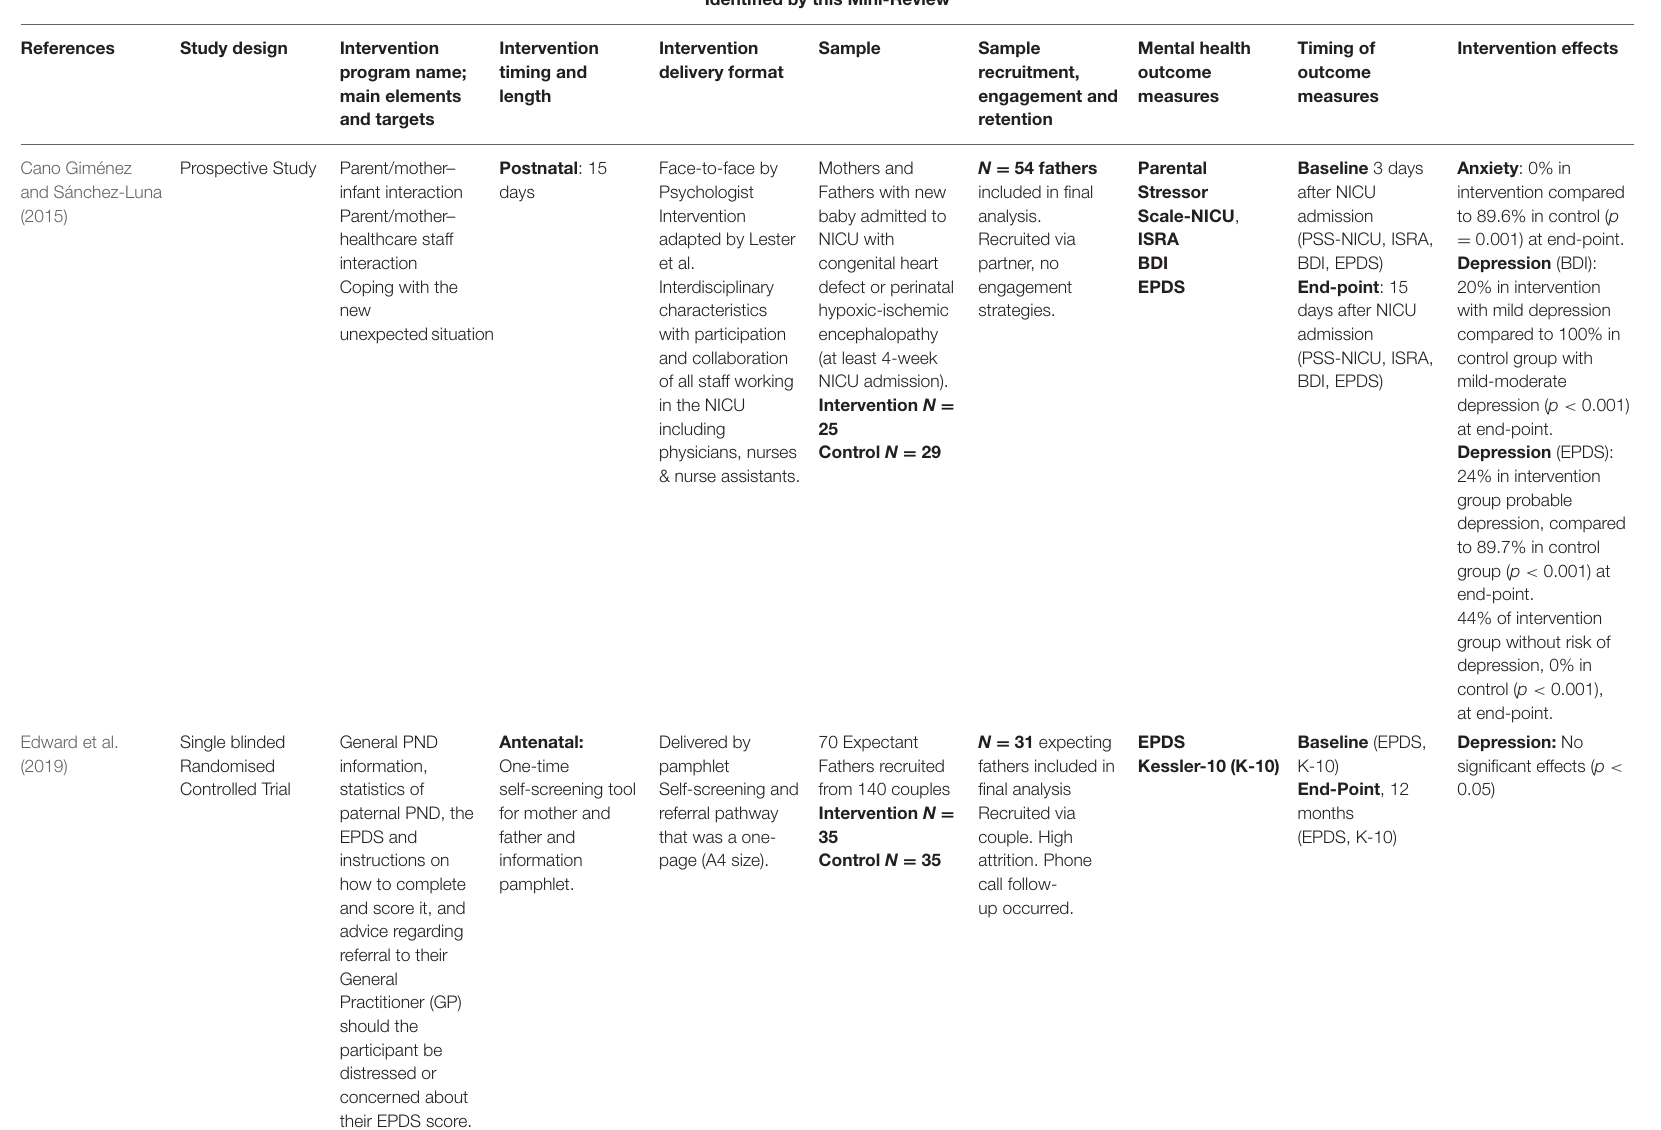
TABLE 2 | Published interventions reporting on men’s perinatal depression or anxiety,